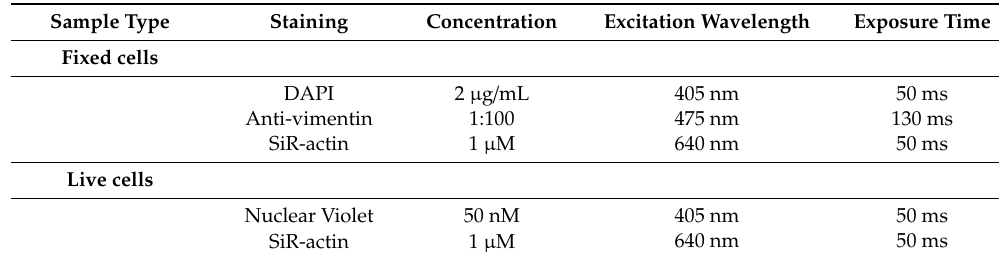
Table 2. Sample staining and imaging parameters.